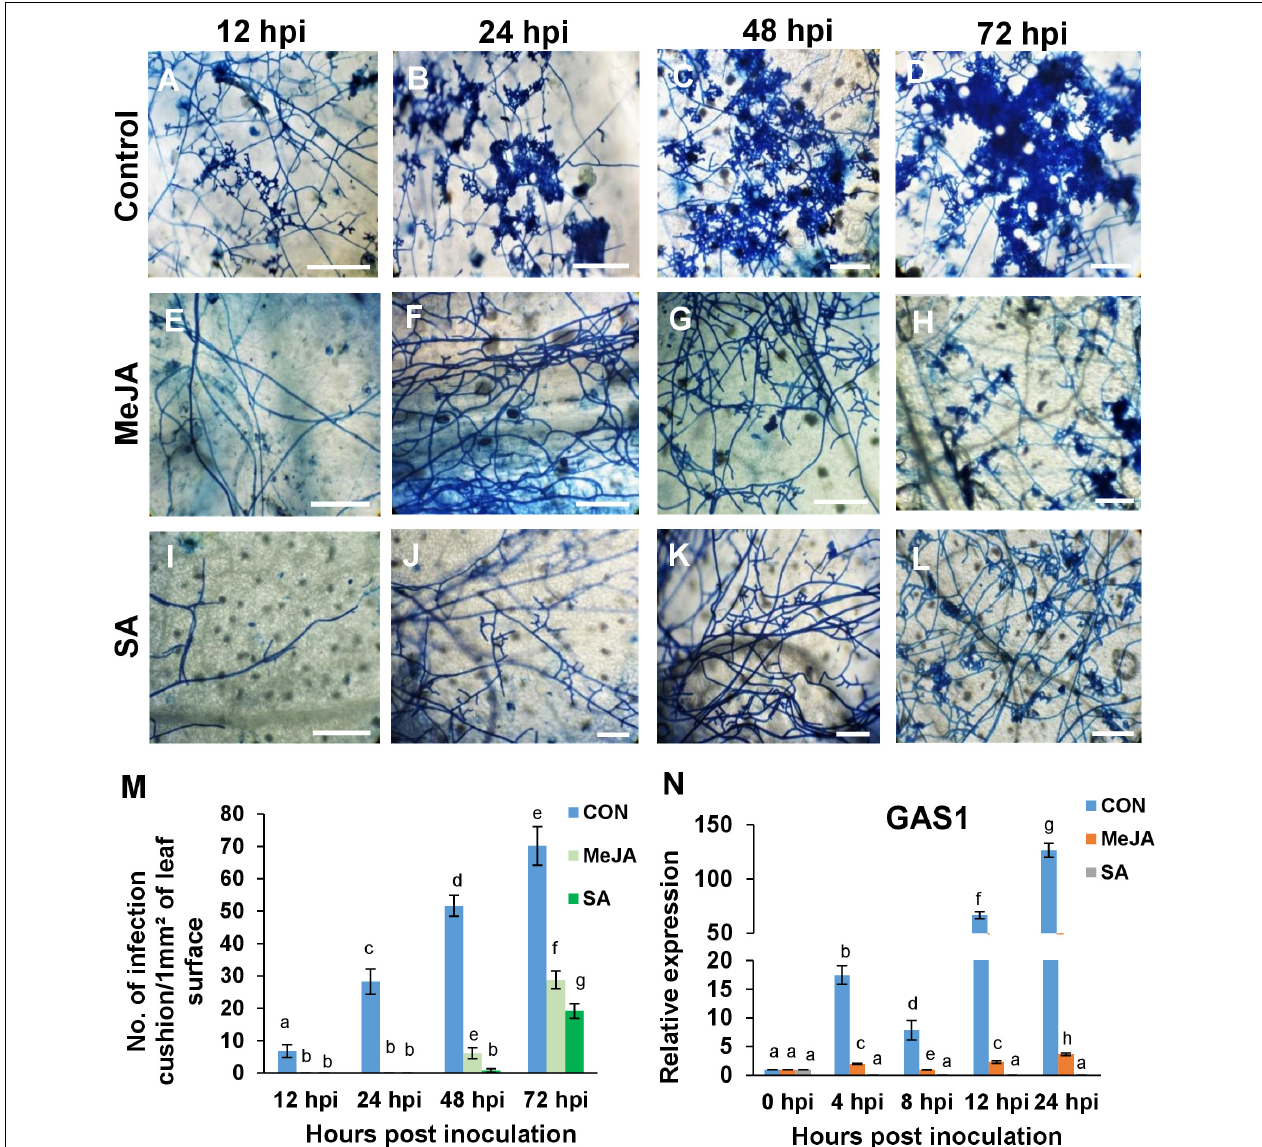
FIGURE 9 | The priming status of the host has direct effect on the frequency of infection cushions, and the expression of the appressorial penetration-associated gene (GAS1) of the pathogen. (A–D) Development of infection cushions (seen as deep blue patches) was initiated as early as 12 h after inoculation in the control plants and progressed rapidly over time, until at 72 hpi, there was coalescence of the infection cushions. (E–H) MeJA priming significantly delayed this process and initiation started as late as 48 hpi. (I–L) Pre-treatment with SA reduced the formation of infection cushions further. At 72 hpi, SA sets showed smaller, more dispersed infection cushions than the MeJA sets. (M) Comparison of the density of infection cushions between the different sets. (N) Relative expression of appressorium-associated protein gene GAS1, showing significantly high transcript level in the control compared to the phytohormone treated sets, over a time course, with the SA sets showing least expression. Bars represent mean ± S.E.M of three independent experiments with three replicates. Different letters indicate significant differences among treatments at p < 0.05, according to Duncan’s multiple range test. Bar = 100 µ